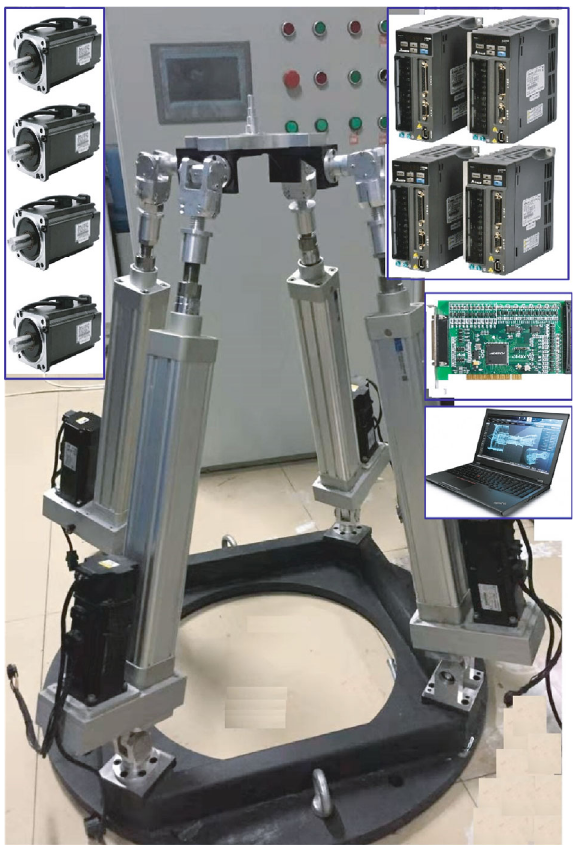
Figure 18: The experimental prototype of the parallel